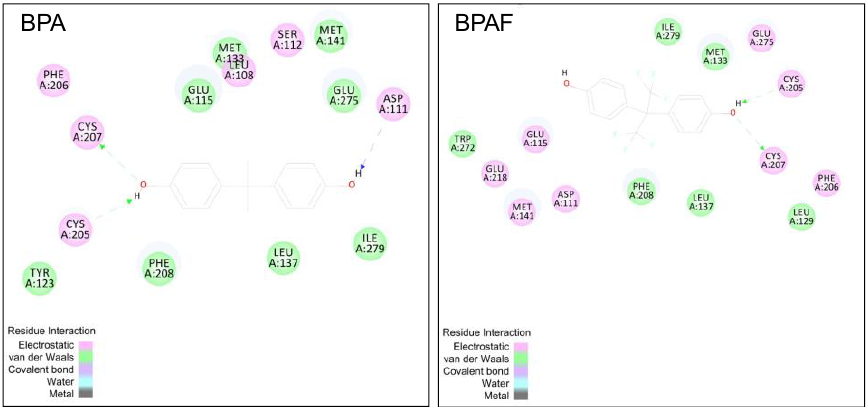
Figure 5. Interaction between BPAF and GPER1. The Discovery Studio 4.0 software package was used to dock BPAF and BPA to GPER1 (Accelrys Software Inc., San Diego, CA, USA). The Cdocker protocol was used to perform the protocol. In this Cdocker protocol, 20 random ligand conformations were generated and refined through grid-based simulated annealing in the binding site of GPER1, and the top ranked postures from the docking were chosen [53].